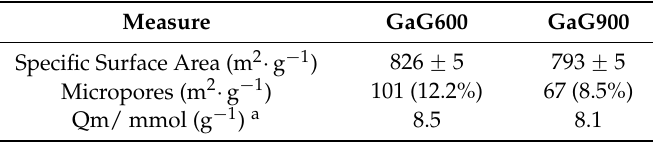
Table 1. Specific surface area and other characteristics of N ‐ carbons.